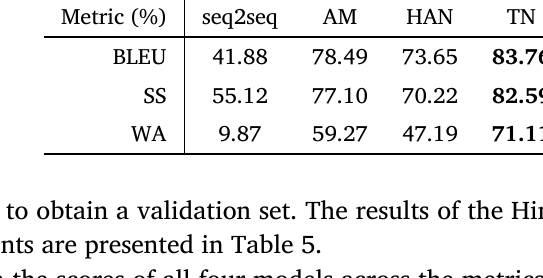
Comparison of evaluation metrics between seq2seq, AM, HAN, and TN for Hindi-Bangla cognate